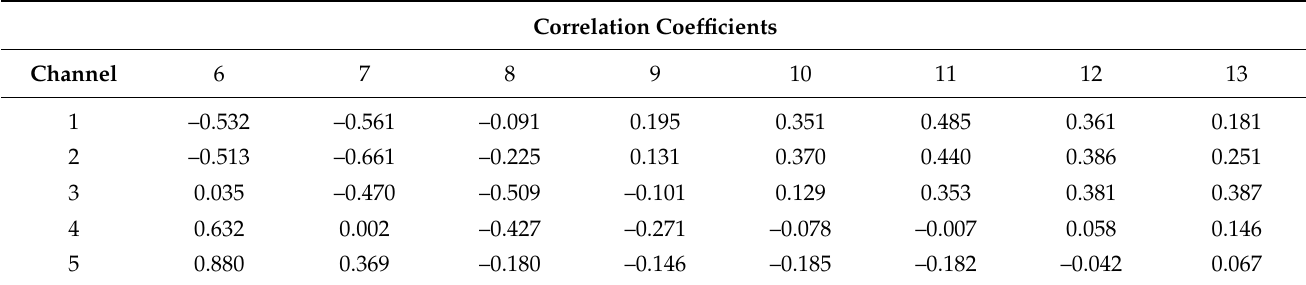
Table 2. The correlation coefficients between the observations of channels with zero surface transmis- sivity and those with non-zero surface